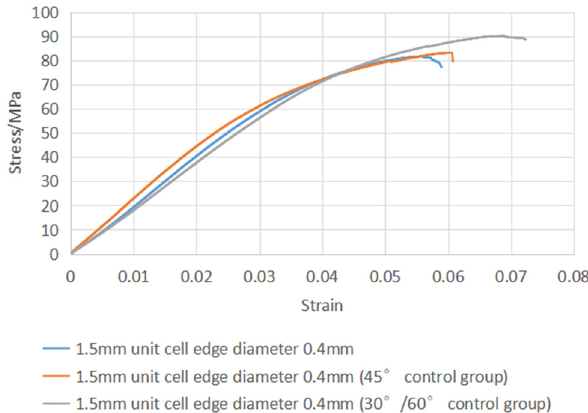
Figure 22: Stress – strain curves of 2 mm unit cell with 0.6 mm edge diameter samples at di ff erent